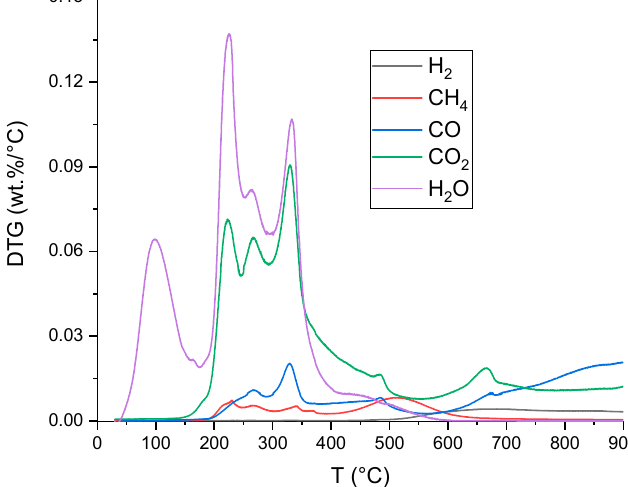
Figure 3. The profile of evolved gases during pyrolysis of beet pulp.